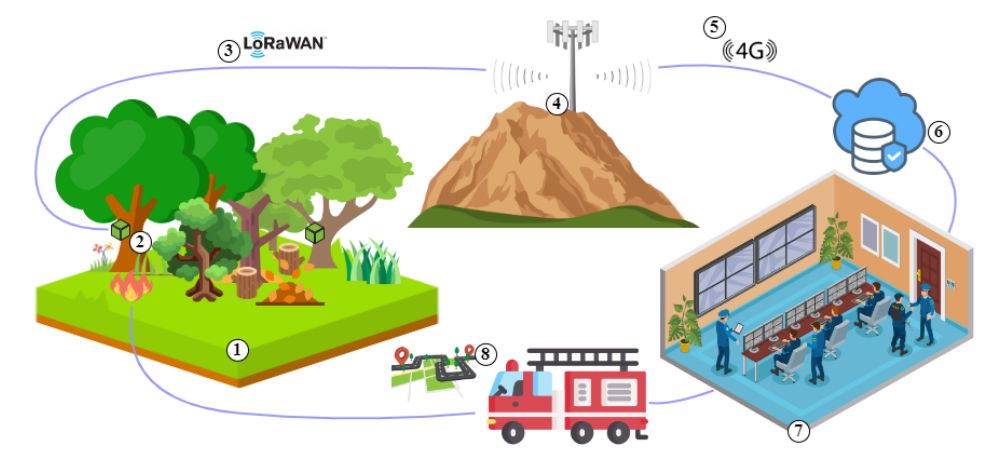
Figure 2. SAFe architecture: 1 (cid:13) Monitored region, 2 (cid:13) Wireless sensor module, 3 (cid:13) Data transmission using LoRaWAN, 4 (cid:13) LoRaWAN gateway, 5 (cid:13) Mobile internet, 6 (cid:13) Cloud server, 7 (cid:13) Control center, and 8 (cid:13) Fire ignition early